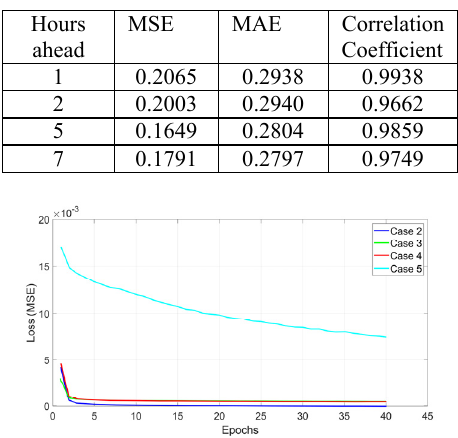
Table 3. Errors and correlation coefficients in Case 3 for all scenarios.